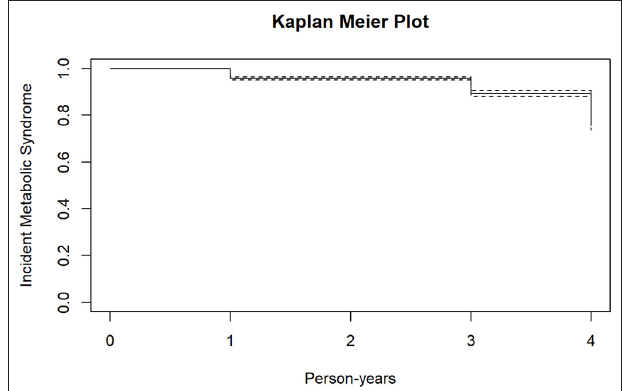
TABLE 4 | Risk of cardiometabolic disease by baseline AST and ALT. Disease status